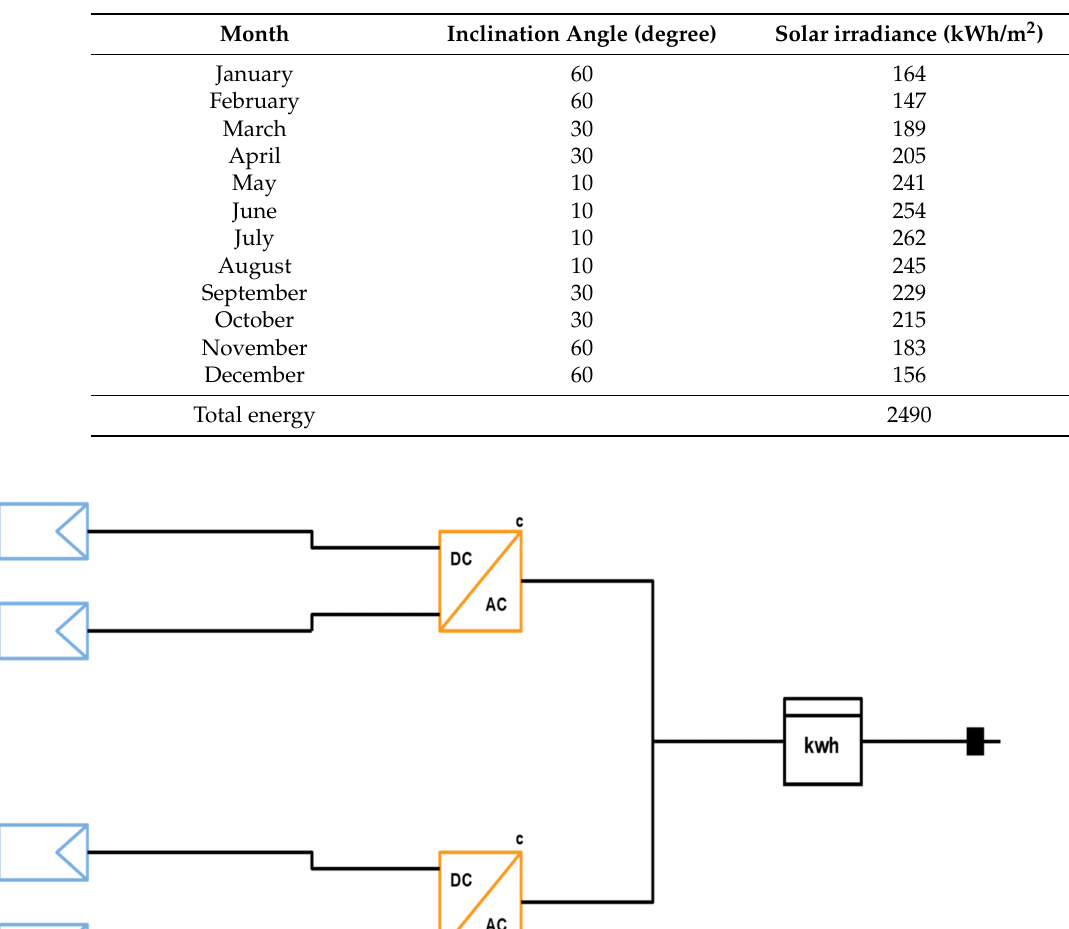
Table 3. Solar irradiance in (kWh/m 2 ) at different inclination angles.